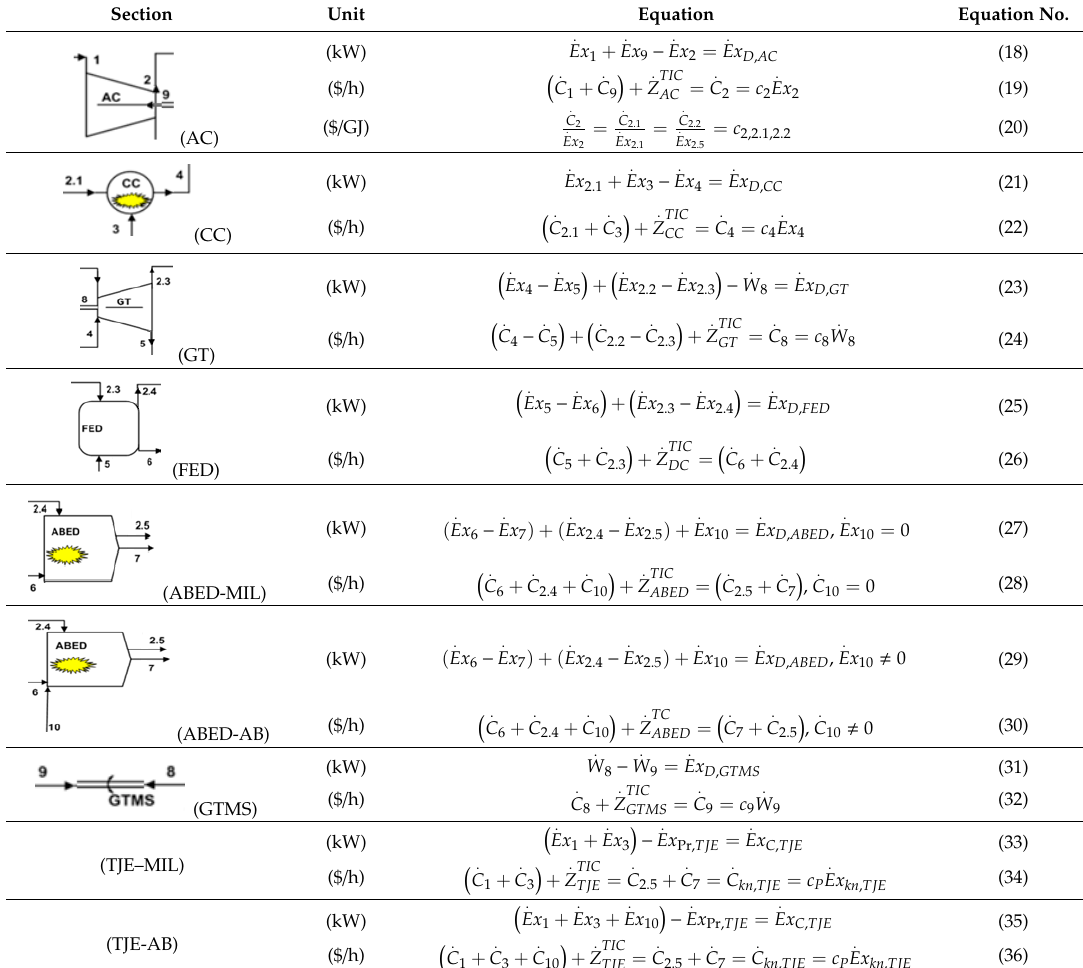
Table 5. Exergy, sustainability and exergoeconomic performance equations for the TJE. Description